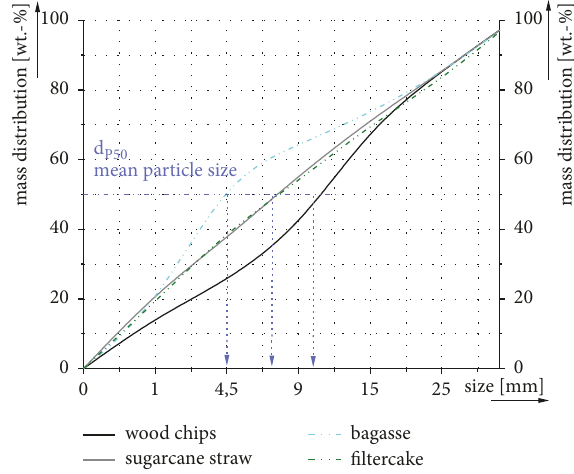
Figure 6: Measured particle size